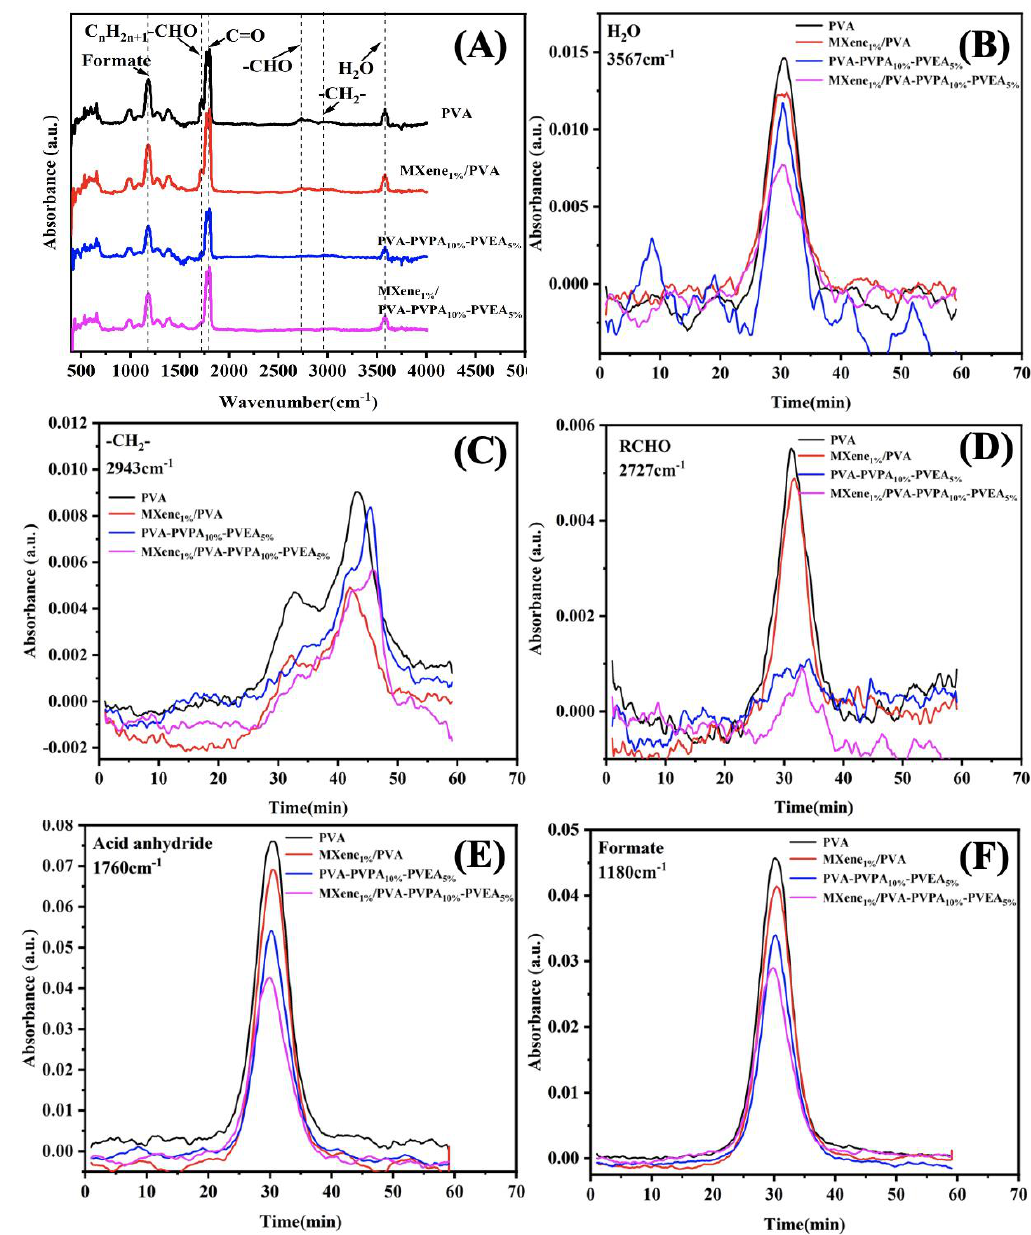
Figure 11. FTIR spectra ( A ) of gaseous pyrolysis products for PVA and MXene/PVA nanocomposites at the maximum evolution rate; Intensities of characteristic peaks for pyrolysis products of PVA and MXene/PVA nanocomposites ( B – F ).